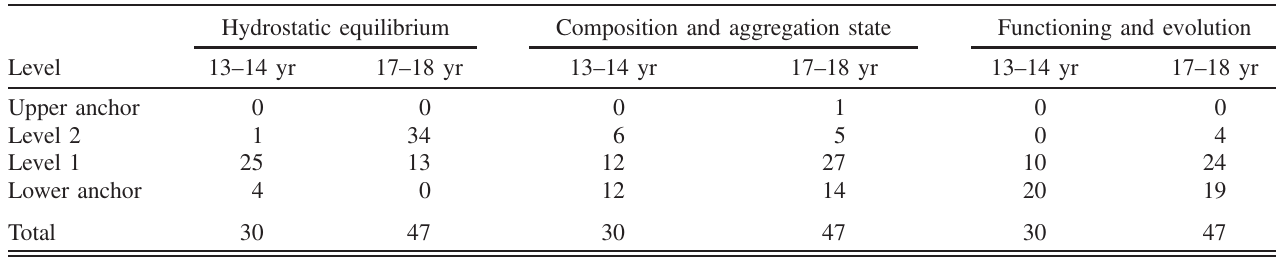
TABLE III. Sample 1 students ’ distribution across LP1